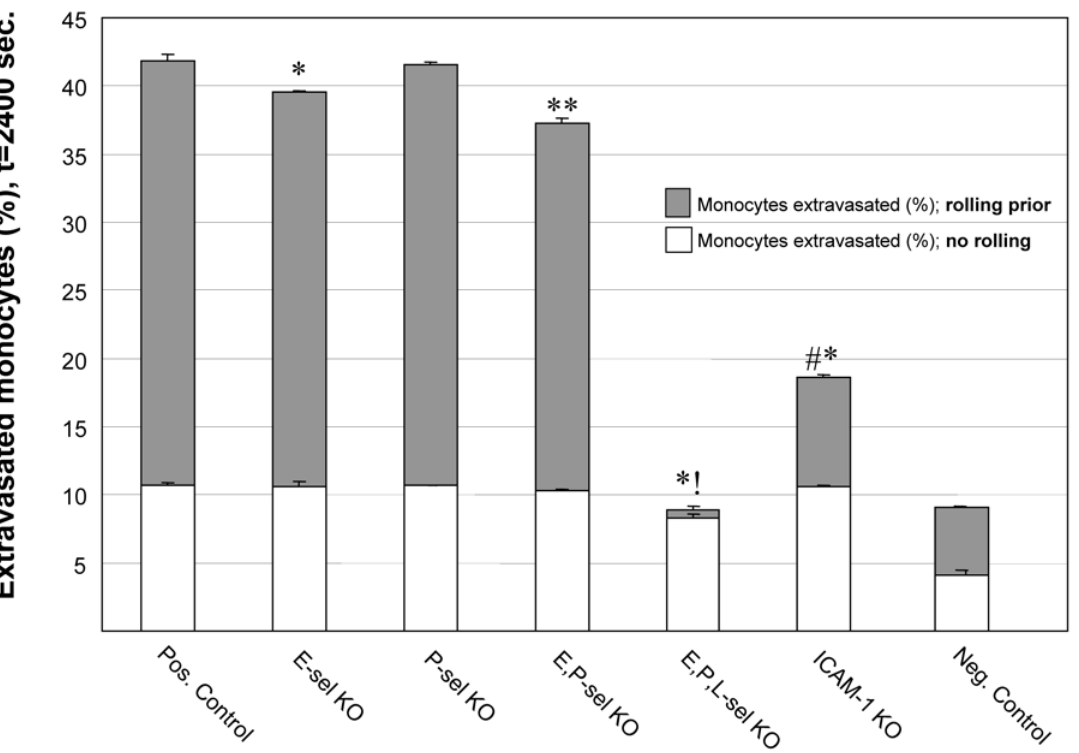
Figure 5. The ABM reproduced expected monocyte trafficking behavior in cellular adhesion molecule knockout experiments. Specifically, levels of monocyte extravasation were unaffected by single selectin knockouts and only marginally affected in simulations of double- selectin knockouts, despite decreases in rolling. Only triple-selectin knockout experiments showed a greater than 80% decrease in monocyte extravasation, which was largely due to an inability to support rolling. Similarly, ICAM-1 knockouts significantly decreased instances of monocyte extravasation, as expected and in agreement with independent experimental findings. Reported are mean values + standard deviation (n=5–9). Significance asserted by comparing total monocytes extravasated (rolling and non-rolling prior) to the positive control (no knockouts) (p , 0.05). Negative controls are included for illustrative purposes only and depict monocytes extravasation in non-ischemic healthy tissue.